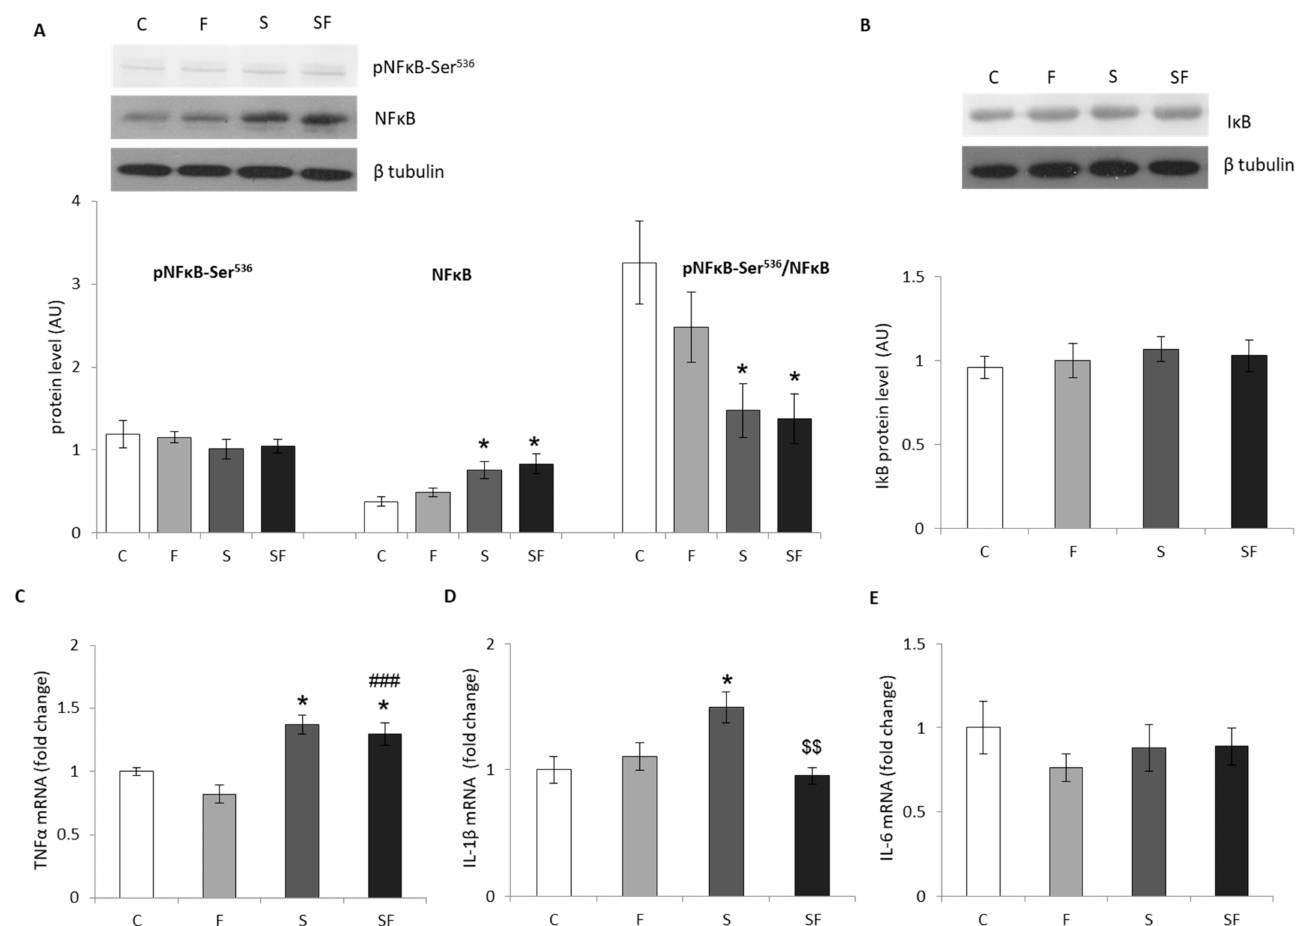
Figure 3. Skeletal muscle inflammatory status in control (C), fructose (F), stress (S), and stress + fructose (SF). Protein levels of NF κ B and pNF κ B-Ser 536 ( A ) and I κ B ( B ) (normalized to β tubulin) were measured by Western blot in the muscle tissue extracts. The values represent the mean ± SEM. TNF α ( C ), IL-1 β ( D ), IL-6 ( E ) and mRNA levels compared to HPRT mRNA were determined by TaqMan real-time PCR in the skeletal muscle. The values represent the mean ± SEM ( n = 8–9 animals per group). All measurements were done in triplicate. Significant between-group differences from post hoc Tukey test are given as follows: * p < 0.05, S, SF vs. C; ### p < 0.001, SF vs. F and $$ p < 0.01, SF vs. S. NF κ B—nuclear factor κ B; I κ B- inhibitor of NF κ B; TNF α —tumor necrosis factor α ; IL-1 β —interleukin 1 β ; IL-6—interleukin 6; HPRT—hypoxanthine